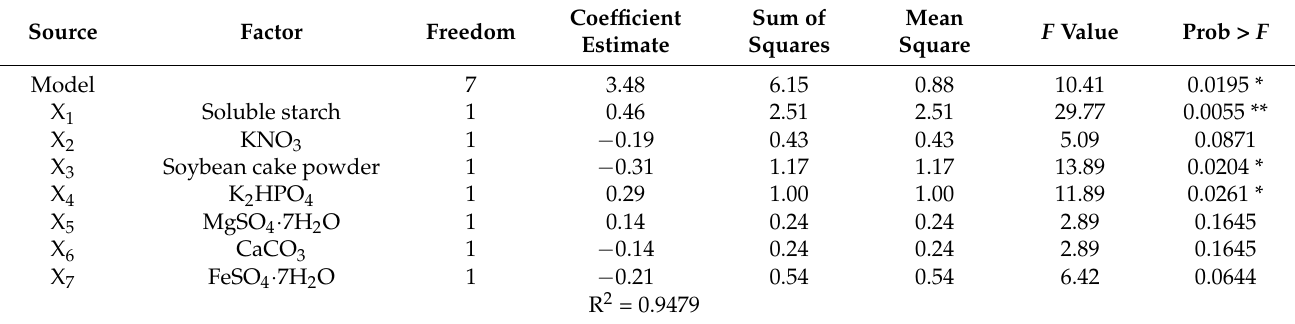
Table 4. Analysis of variance of PBD.